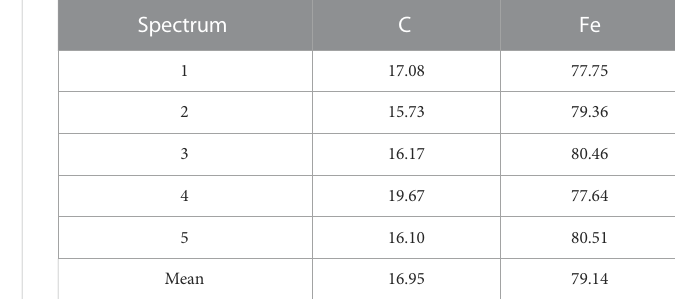
TABLE 4 Corresponding EDS